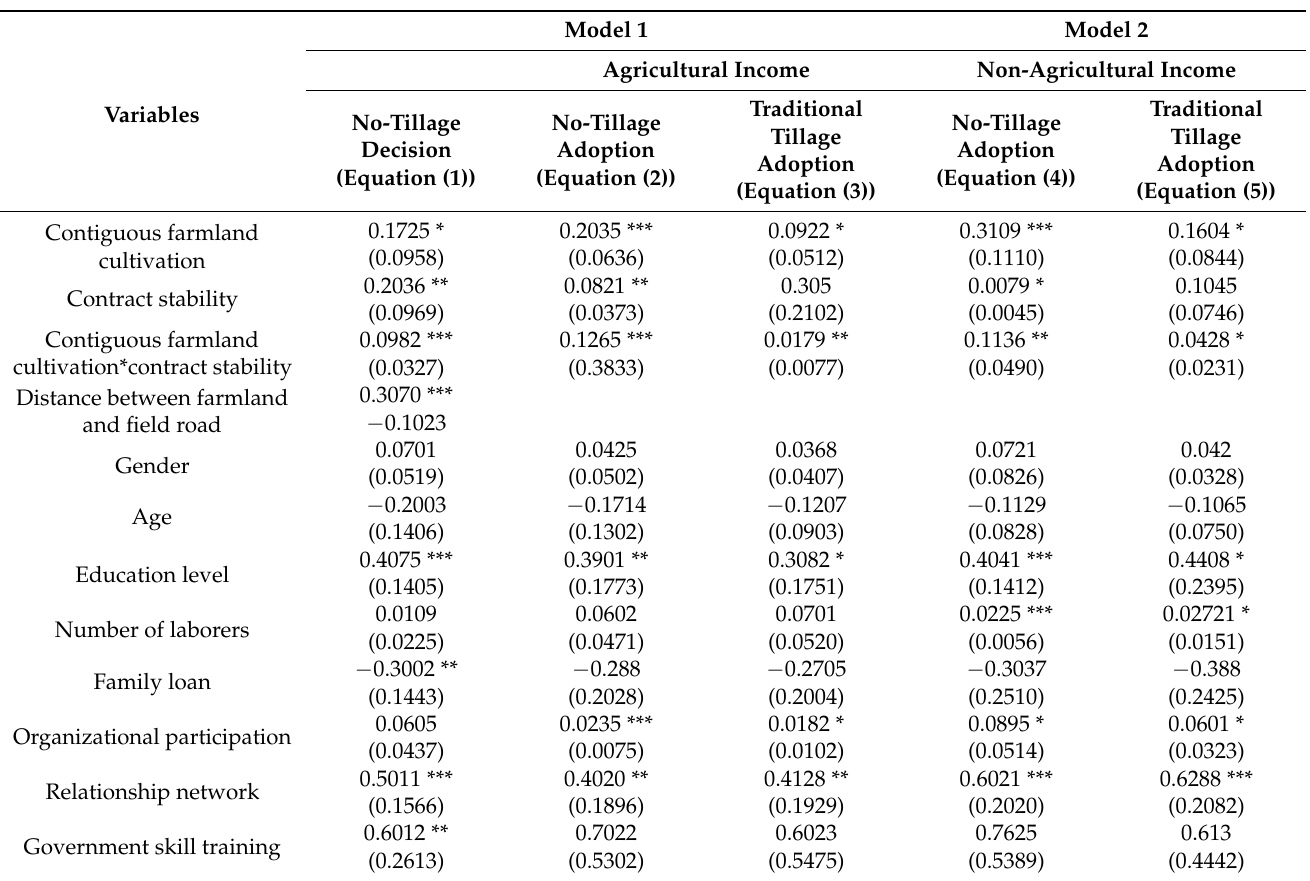
Table 2. Regression results of ESR